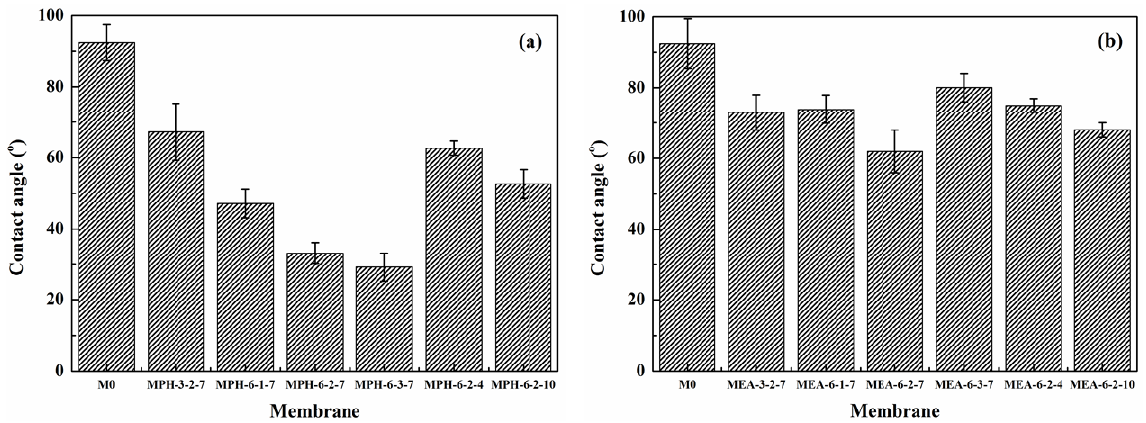
Figure 5. Contact angles of various membranes ( a ) polyMPDSAH-g-PVDF membrane; ( b ) polyMEDSA-g-PVDF